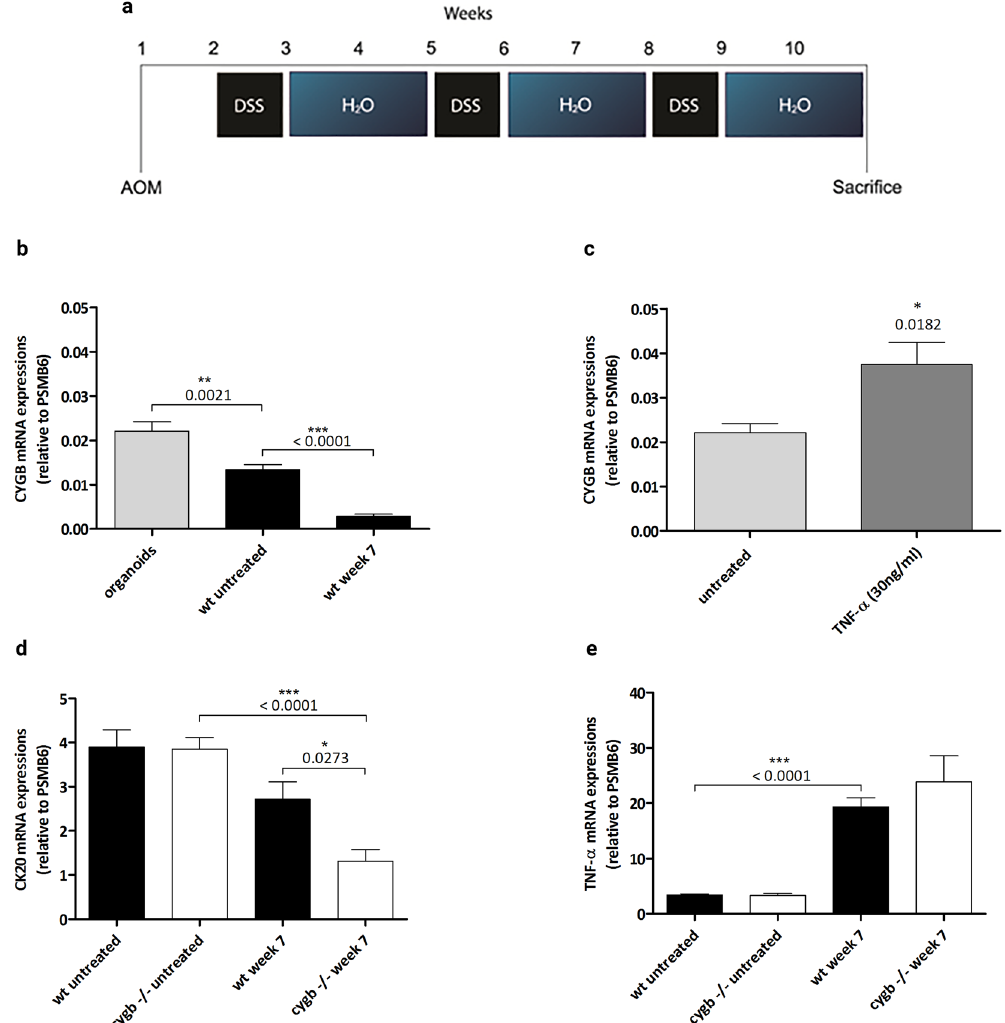
Figure 1. Cygb, Ck20, and TNF- α mRNA expression levels. ( a ) Timeline of the AOM/DSS treatment. Mice were injected i.p. with AOM (7.4 mg/kg), followed by three cycles of 3% DSS in weeks 2, 5 and 8. ( b ) Cygb mRNA expression in cultured organoids from isolated WT colonic epithelial crypts (n = 6), AOM/DSS- treated colonic tissue from week 7 (n = 8) and untreated control WT mice (n = 8). Real-time RT-qPCR was performed to quantify Cygb mRNA expression levels, which were normalized to that of PSMB6. ( c ) Cygb mRNA expression in colonic organoids from WT C57BL/6 mice that were untreated (n = 6) or treated with 30 ng/ml TNF- α (24 h) (n = 6). ( d ) Ck20 mRNA expression in AOM/DSS-treated colonic tissue from week 7, WT (n = 8), Cygb − / − (n = 5) and untreated control WT (n = 8) and Cygb − / − mice (n = 8). ( e ) TNF- α mRNA expression in AOM/DSS-treated colonic tissue from week 7, WT (n = 8), Cygb − / − (n = 5) and untreated control WT (n = 8) and Cygb − / − mice (n = 8). Data are shown as the mean ± SEM. Statistical analysis was performed using Student’s t-test, and P values are shown. P values < 0.05 were considered statistically